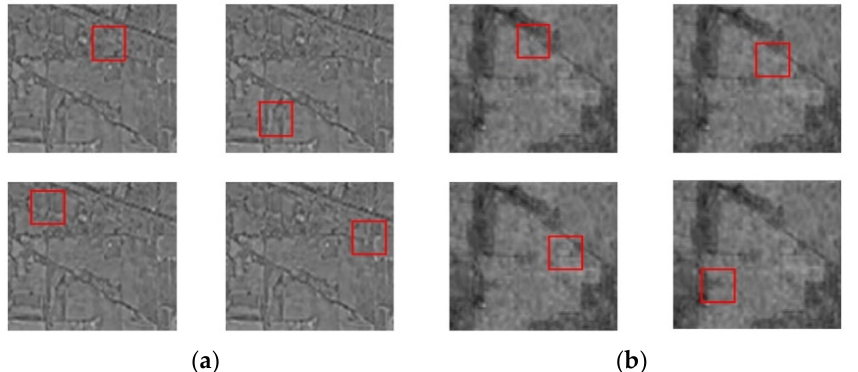
Figure 3. Cutout regularization on Indian Pines dataset with two examples: ( a ) example 1 and ( b ) example 2.